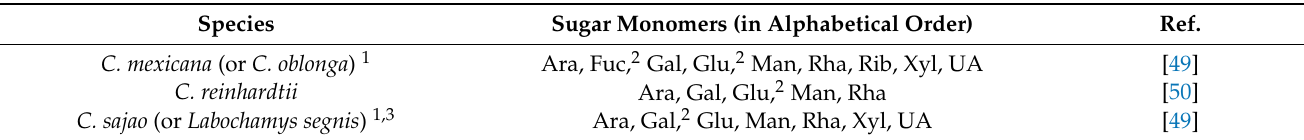
Table 1. Sugar monomers of polysaccharides in Chlamydomonas microalgae where Ara arabinose, Fuc fucose, Gal galctose, Glu glucose, Man mannose, Rha rhamnose, Rib ribose, Xyl xylose, UA uronic acids. Adapted from